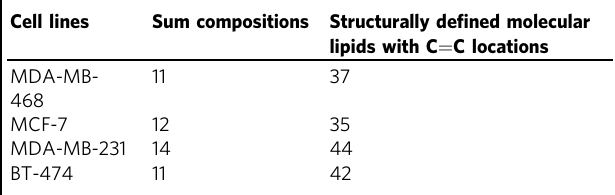
Table 1 The number of lipid isomers detected in single cells of different cell